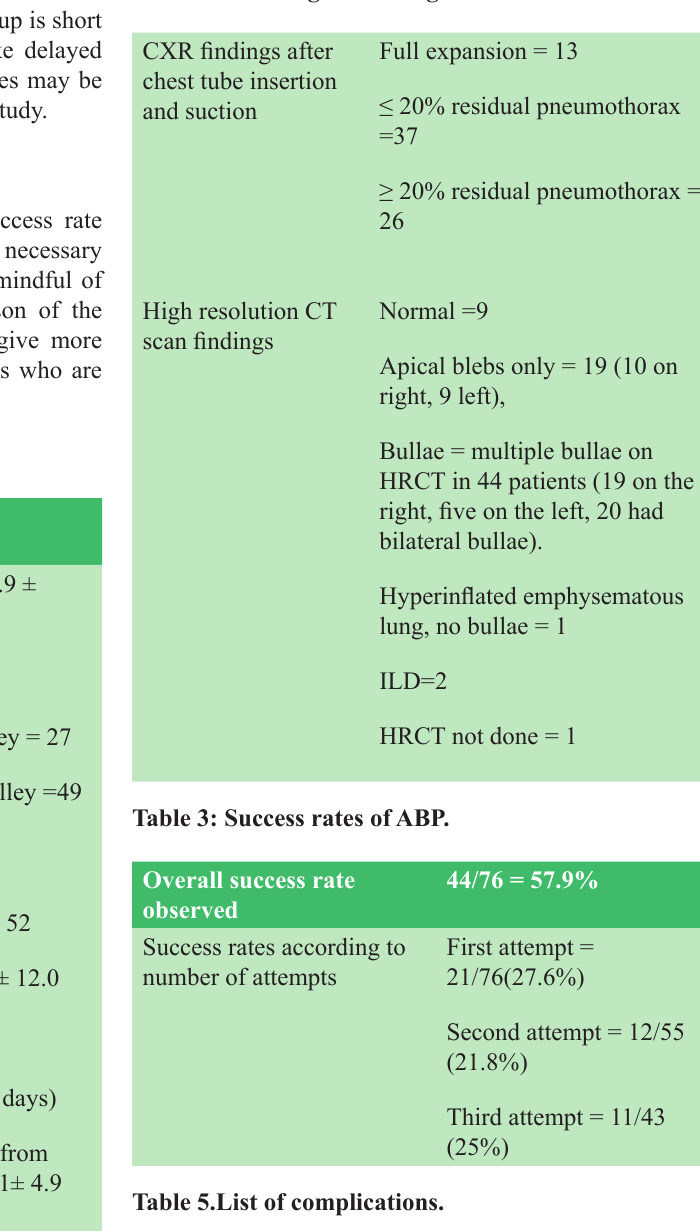
Table 2: Radiological findings: